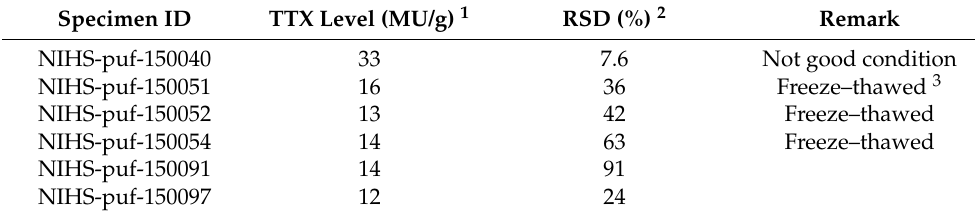
Figure 4. The LC–MS/MS MRM ( m/z 320.2 > m/z 162.1 and m/z 320.2 > m/z 302.0) chromatograms of reference tetrodotoxin and a representative sample. ( a , b ), TTX reference solution (10 ng/mL); ( c , d ), flesh and skin samples, respectively, of specimen NIHS-140040. Analytical columns used were Inertsil Amide (3 µ m, 2.1 × 75 mm) for ( a , c ), and InertSustain Amide (3 µ m, 2.1 × 75 mm) for ( b , d ). Table 3. TTX levels in the flesh samples randomly taken from fillets judged as toxic (>10